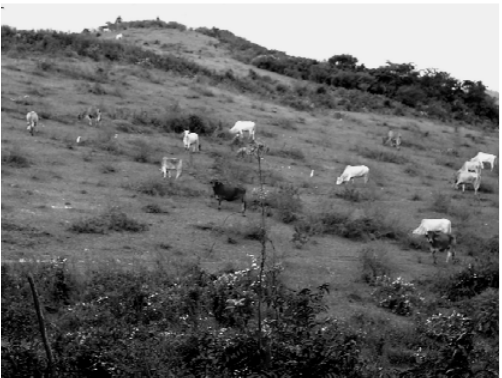
Figure 9. Marabú